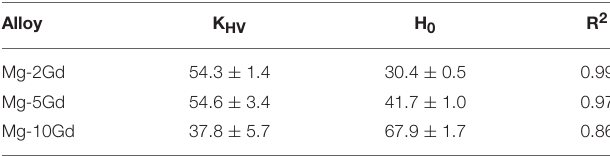
TABLE 3 | Coefficients for relation of hardness to grain size including standard